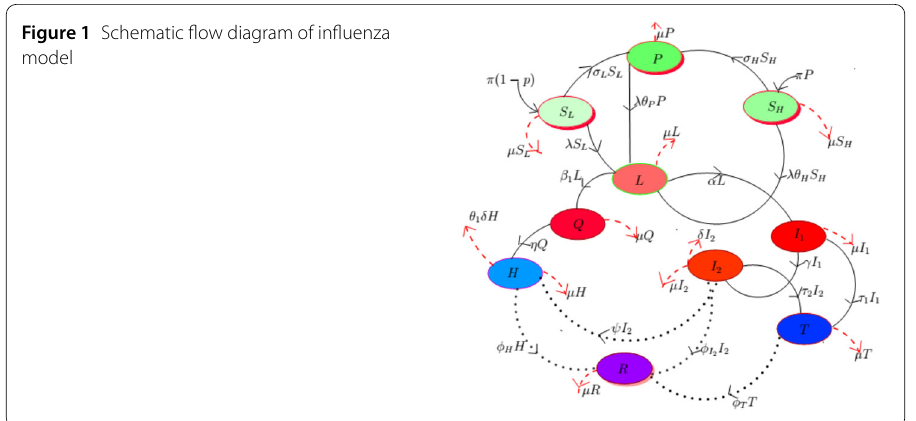
Figure 1 Schematic flow diagram of influenza